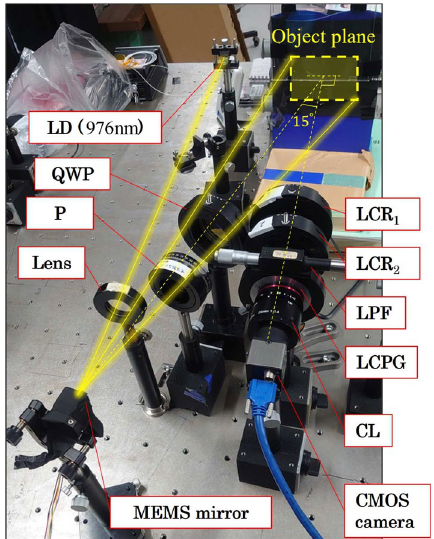
Figure 10. Photographs of the experimentally assembled PPPI